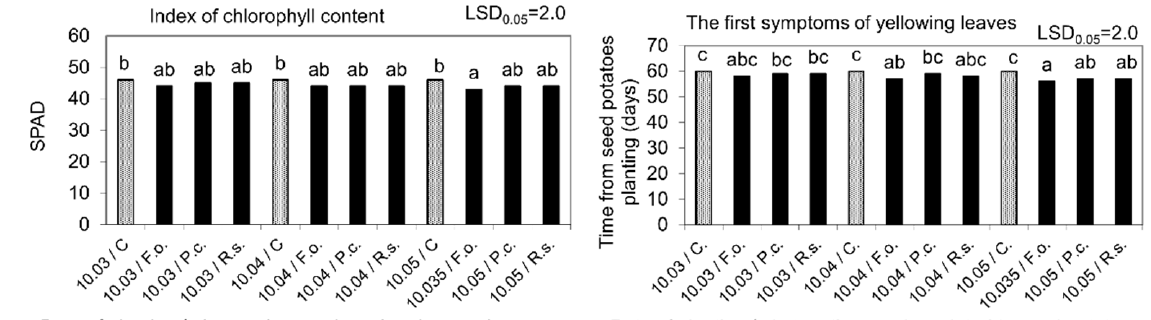
Figure 8. Gas exchange in potato leaves, as affected by seed potatoes storage at 4 °C from harvest until inoculation with phytopathogens on 10 February and then at 15 °C and 80% RH before plant- ing in the soil on 10 March, 10 April, and 10 May. C—Control, Fo— F. oxysporum , Pc—P . corotovorum , Rs— R. solani . Means marked with the same letters do not differ statistically at the significance level p = 0.05. LSD was calculated at the significance level of p = 0.05.